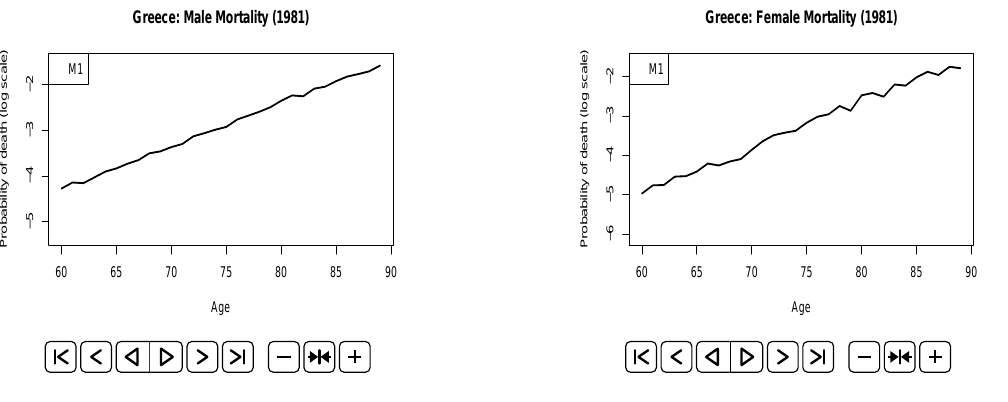
Figure A1. M 1 for males and females.